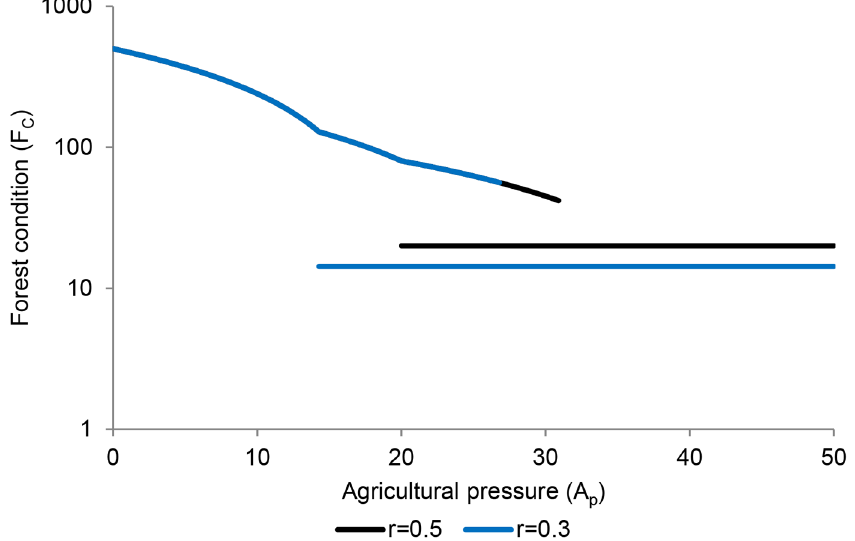
Fig 3. Forest condition as a function of agricultural pressure. The lines correspond to two different internal recruitment rates ( r = 0.3 and r = 0.5). The diagonal lines correspond to the forested stable state and the horizontal lines the deforested state. Note that in the forested state, the lines for the two values of r overlap exactly for most values of agricultural pressure. For intermediate values of A P two values of forest condition ( F C ) are possible due to hysteresis in the system. These results are from the Borneo (good soil)